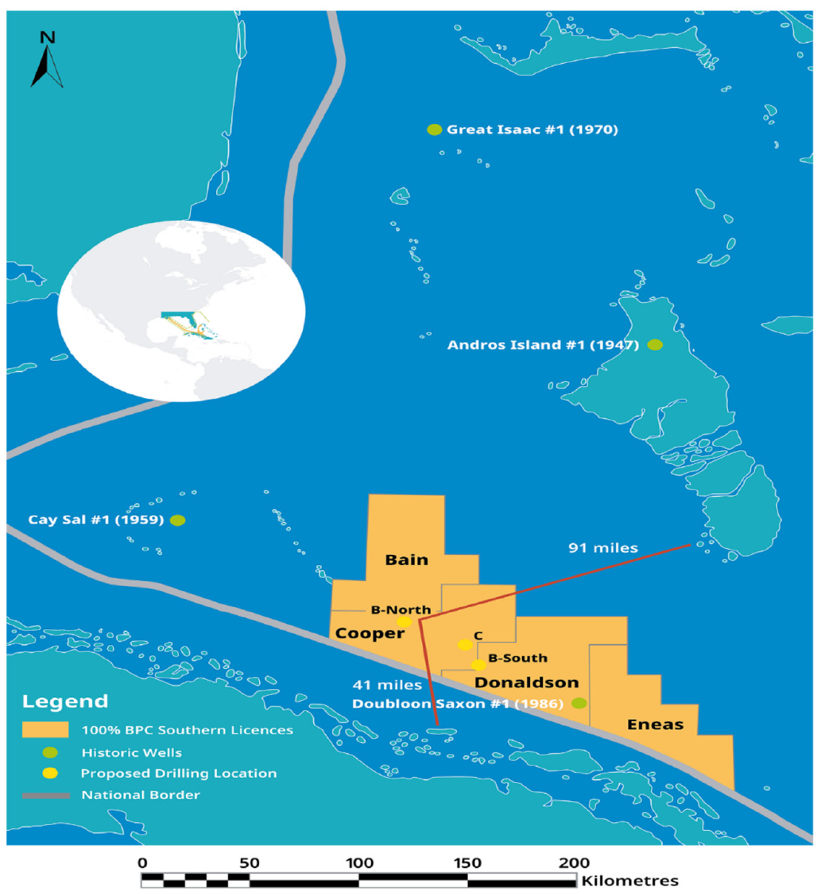
Figure 2. Historic wells, proposed drilling locations and Southern Licences (adapted from BPC [83]).